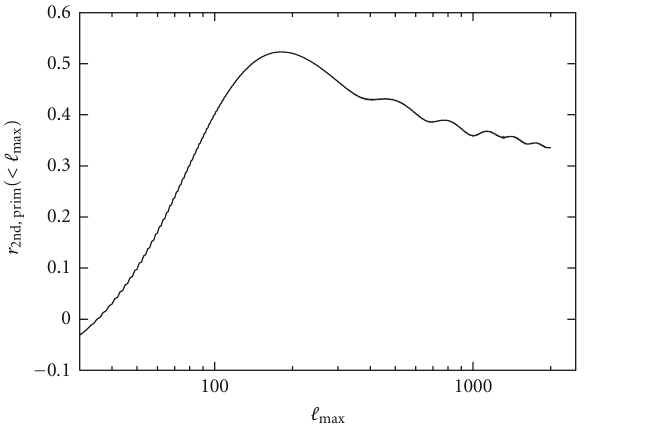
Figure 6: Projected uncertainty of f NL with (dashed) and without (solid) the second-order bispectrum marginalized